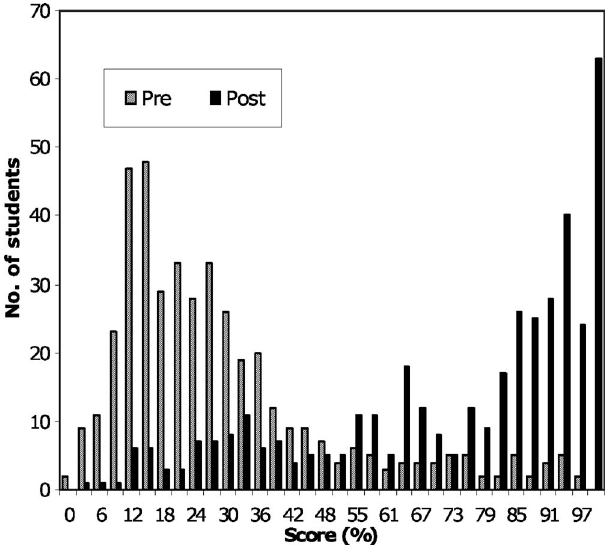
FIG. 1. Pre and post results for FMCE exam (cid:1) spring 2004 (cid:2) . Scoring of this exam follows Thornton (cid:1) Ref. 41 (cid:2) . All students who took the exam are shown in the histogram. Pretest (cid:1) N =486 (cid:2) average 29%, median 23%. Post-test (cid:1) N =400 (cid:2) average 74%, median